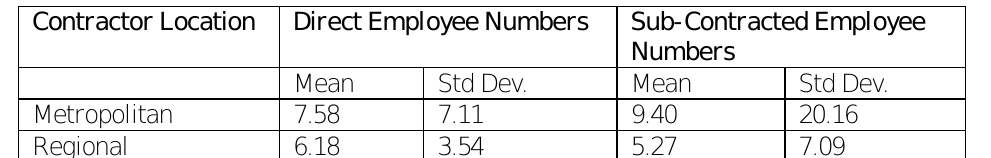
Contractor Location